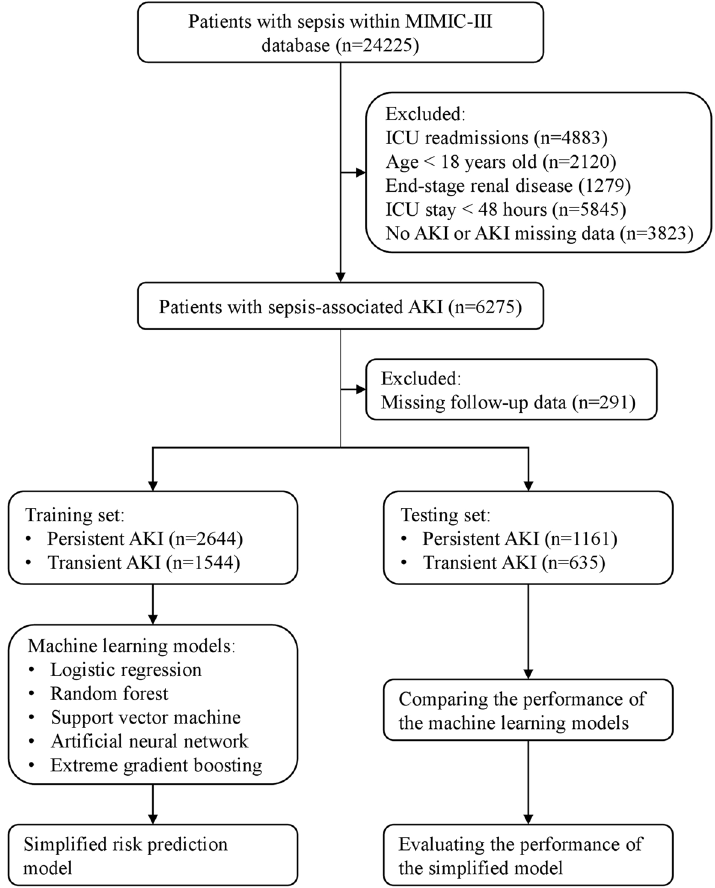
Figure 1. Flow diagram of patient selection, model establishment and internal validation. MIMIC-III, Medical Information Mart for Intensive Care III; ICU, intensive care unit; AKI, acute kidney